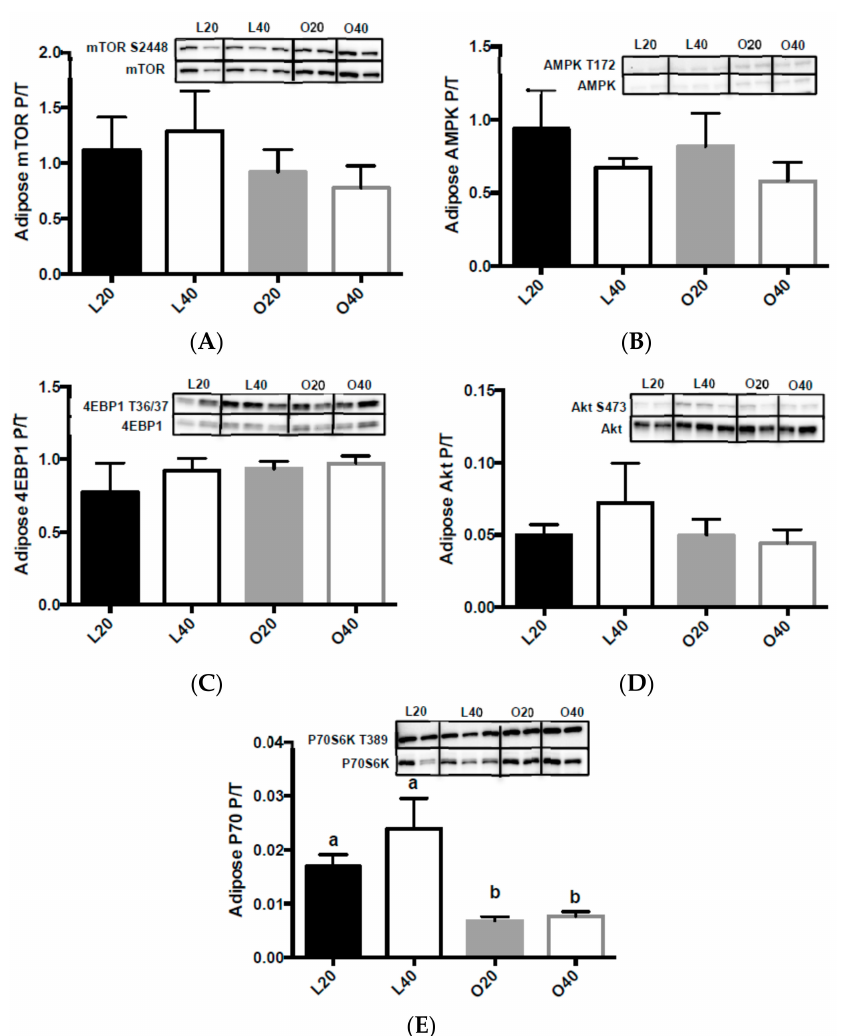
Figure 7. Changes in mammalian target of rapamycin complex 1 (mTORC1) signaling in epididymal adipose tissue following 12-weeks of consuming either a 20% protein ( n = 8 per group) or 40% protein diet ( n = 10 per group) in lean control (L) or obese Zucker (O) rats. Representative blots are shown, all bands are from the same blot. ( A ) Mammalian target of rapamycin complex 1 (mTORC1) phosphorylation (S2448) over total protein; ( B ) 5 (cid:48) AMP-activated protein kinase (AMPK) phosphorylation (T172) over total protein; ( C ) Eukaryotic translation initiation factor 4E binding protein 1 (4EBP1) phosphorylation (S65) over total protein; ( D ) Protein kinase B (Akt) phosphorylation (S473) over total protein; ( E ) Ribosomal protein S6 kinase 1 (P70) phosphorylation (T389) over total protein. Values are means + SEM. Data was analyzed using one-way ANOVA. Values without a common letter differ, p < 0.05. L20, lean 20% protein; L40, lean 40% protein; O20, obese 20% protein; O40, obese 40% protein; P/T, phosphorylated/total protein. Figure without boxes separating treatment groups can be found in Supplementary Data Figure